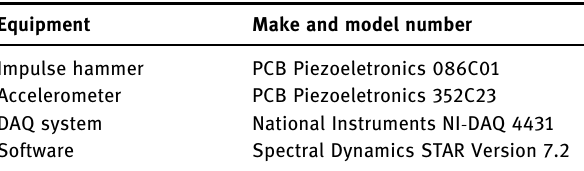
Table 4: Modal analysis experimental setup details Equipment